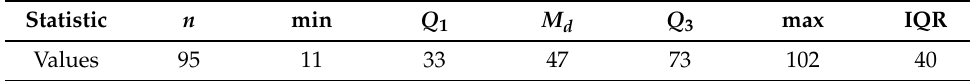
Table 7. Descriptive statistics for the COVID-19 data set of